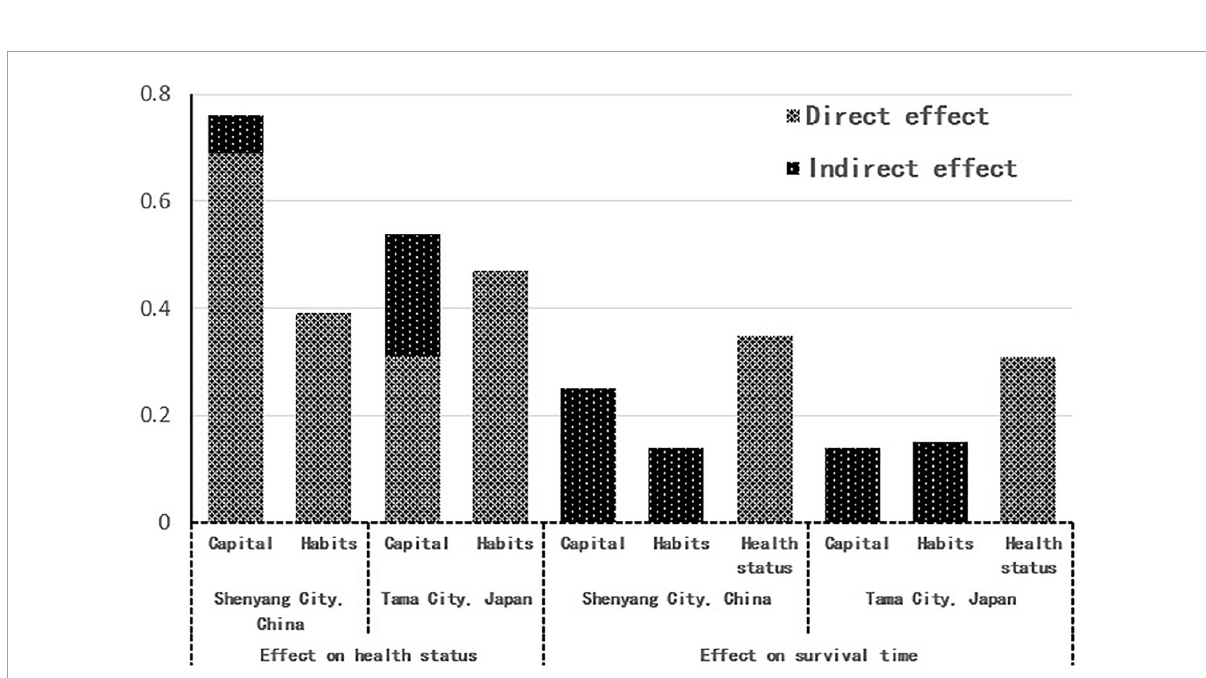
FIGURE7 Direct and indirect effects of capital and habitus on health status and survival